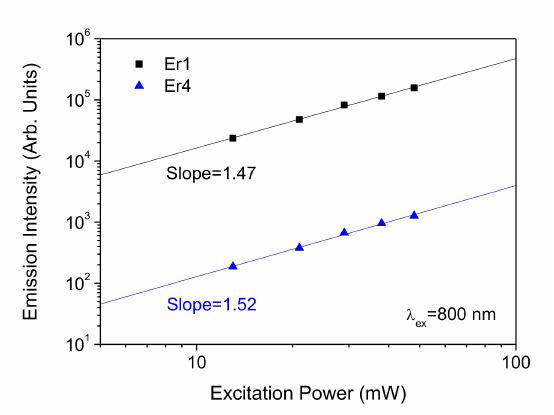
Figure 7. Dependence of green upconversion emission intensity on excitation power for Er 3+ ions under excitation at 800